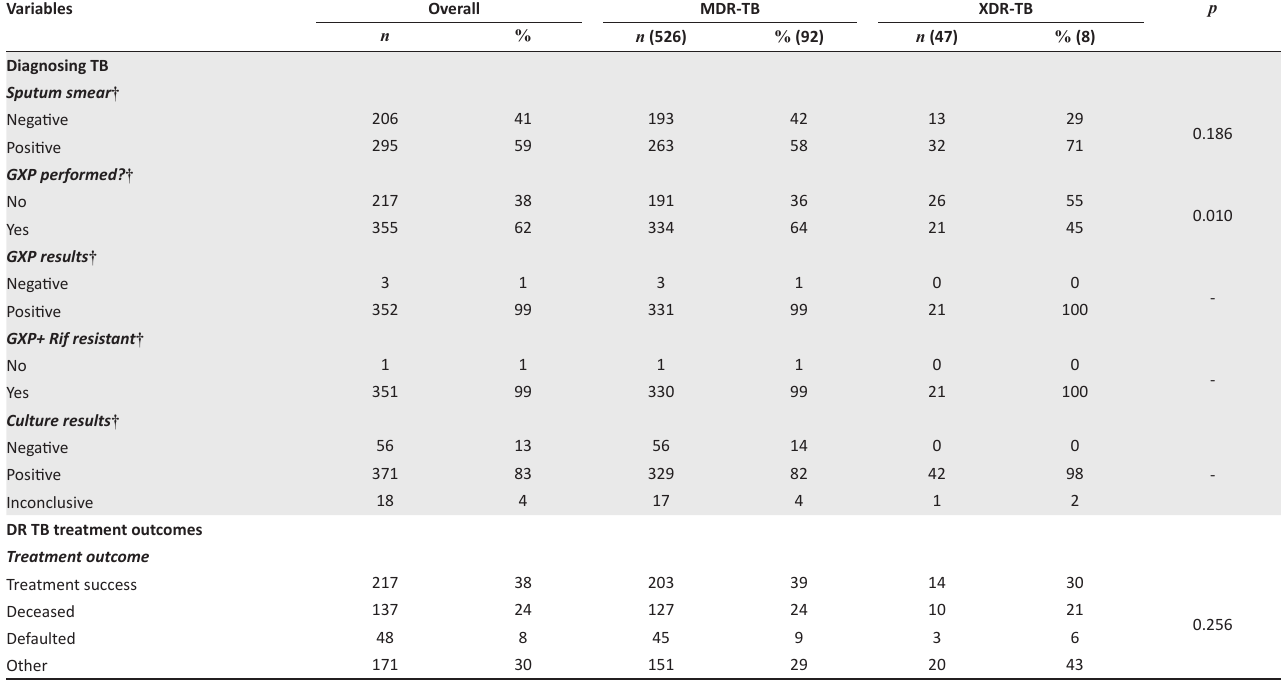
TABLE 3: Drug-resistant tuberculosis diagnosis and treatment outcome data of participants.